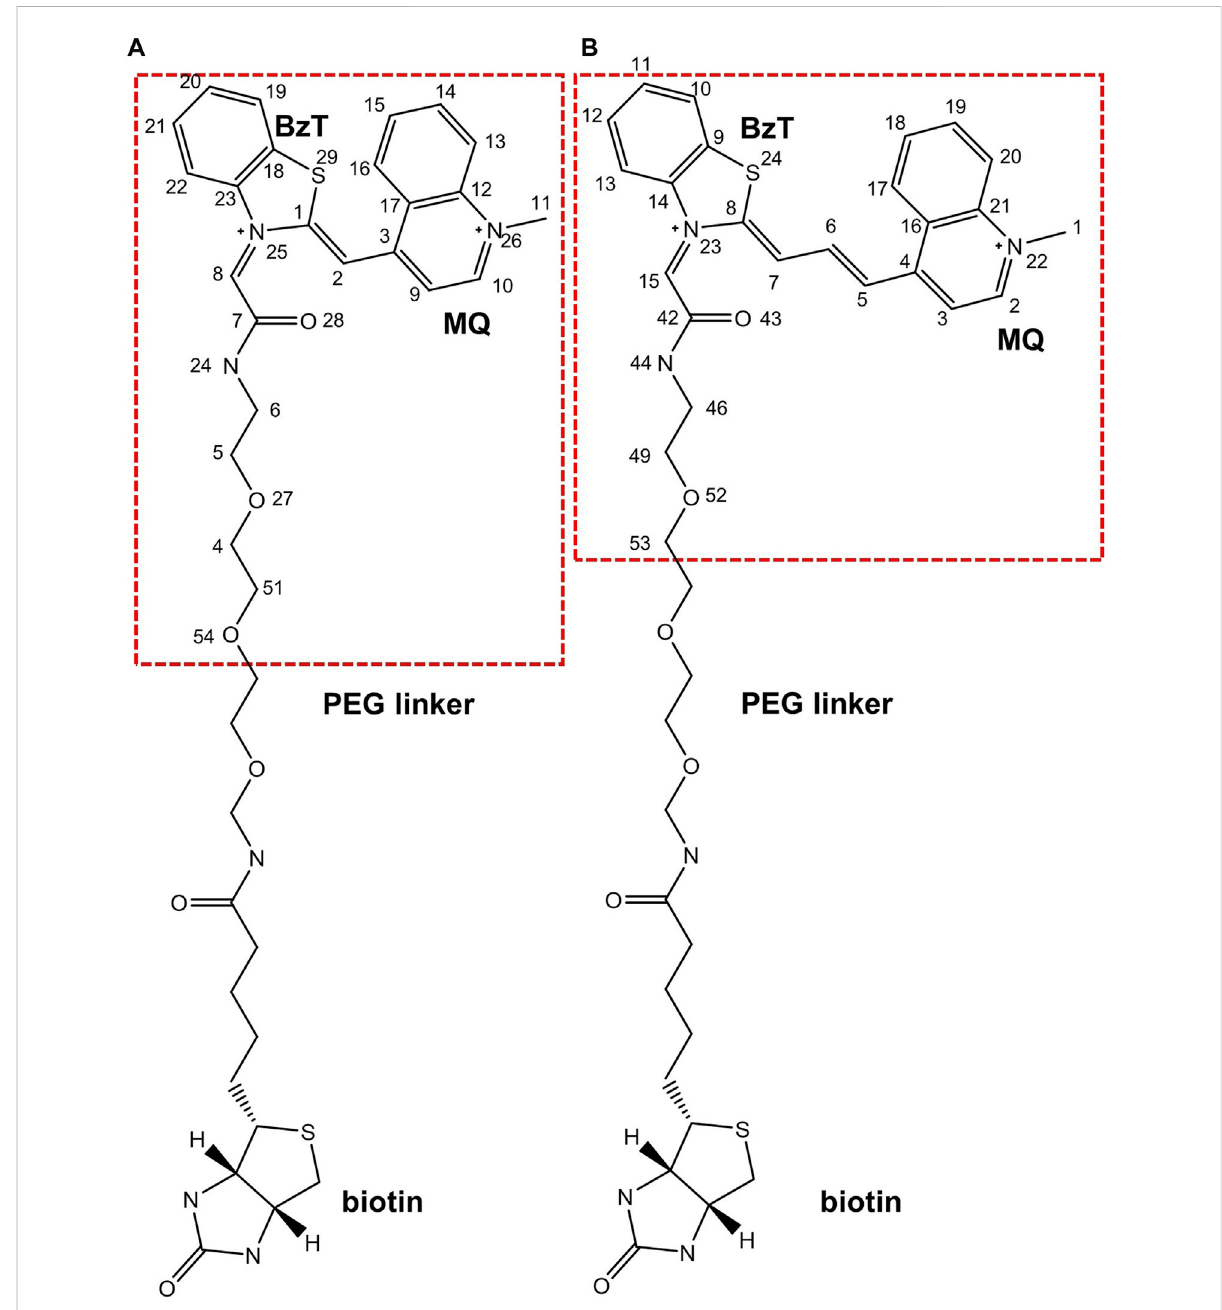
FIGURE 2 Chemical structures of (A) . TO1-Biotin and (B) . TO3-Biotin. BzT means benzothiazole and MQ mean methyl quinoline. The red dash box represents the part inside the binding